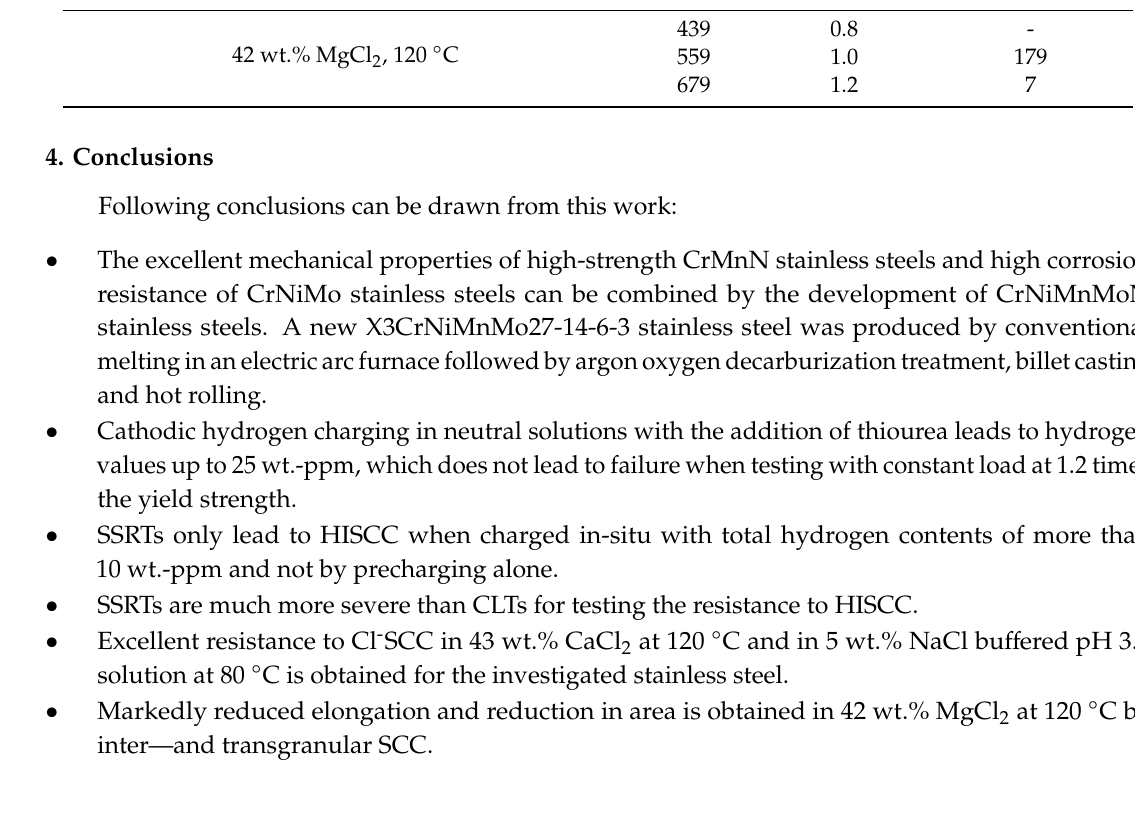
Table 4. CLT Results for HISCC and Cl - SCC